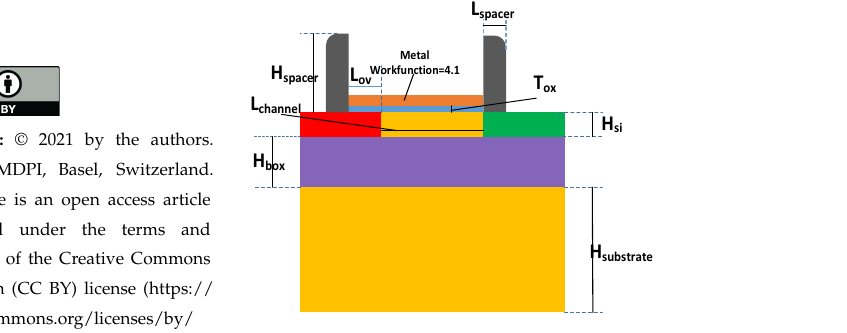
Figure 1. Cross-sectional view of SOI-TFET. Table 1. Device parameters used for the simulation.